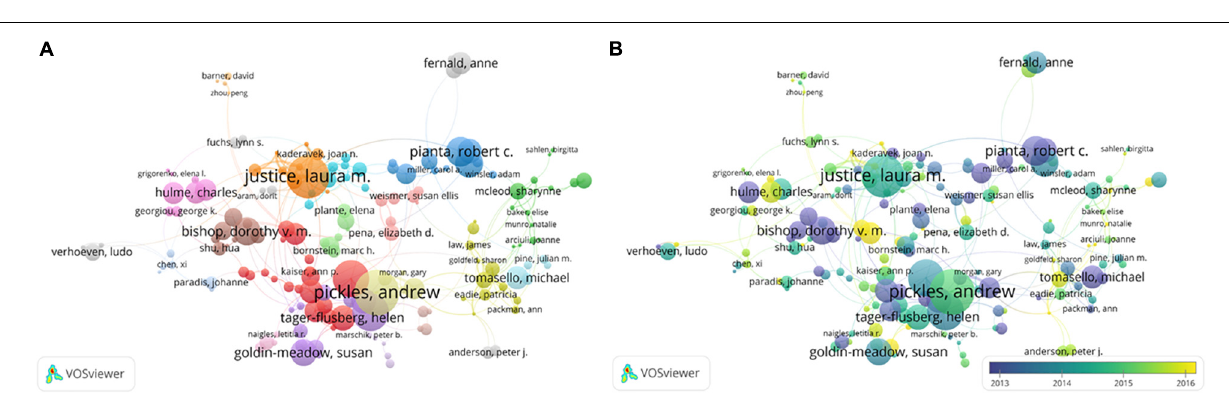
( n = 60), Leonard, L. B. ( n = 59), Justice, L. M. ( n = 46),